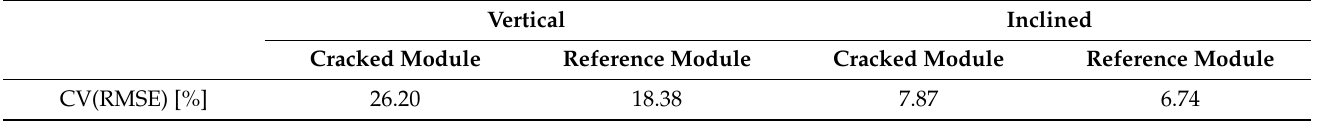
Table 3. CVRMSE comparison between measured and simulated